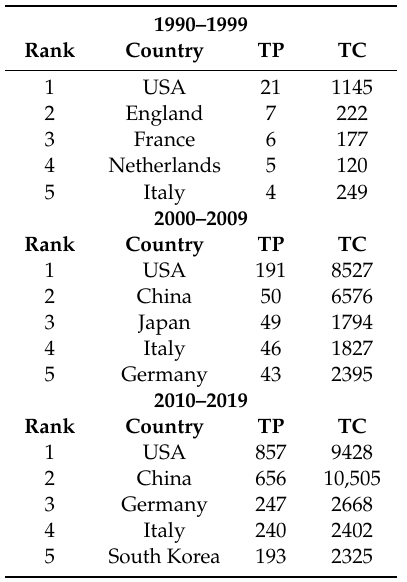
Table 2. Most productive and influential countries throughout time for Set 2.